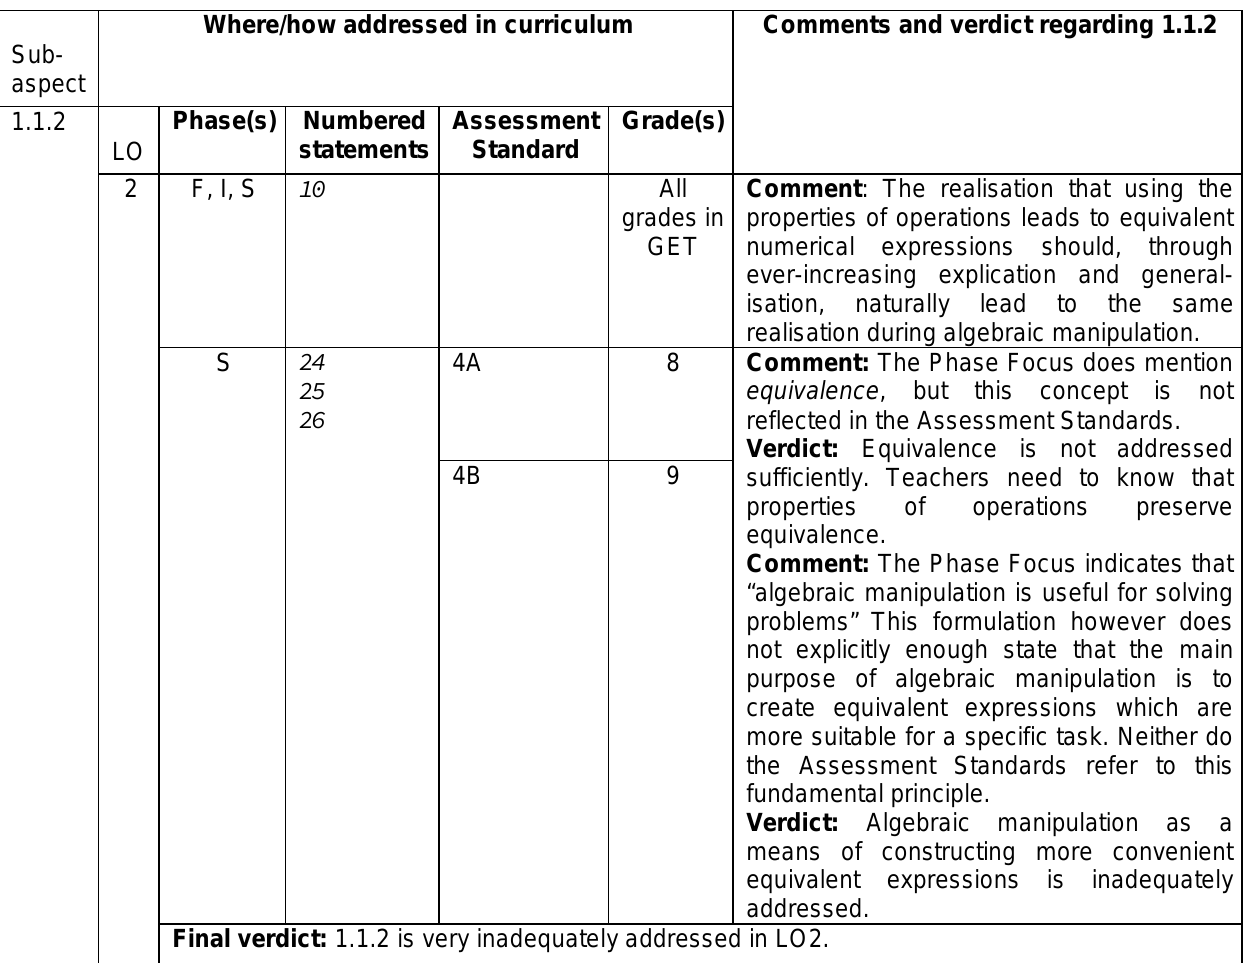
Aspect 1 (cont.): enable learners to experience and appreciate algebra as generalised arithmetic